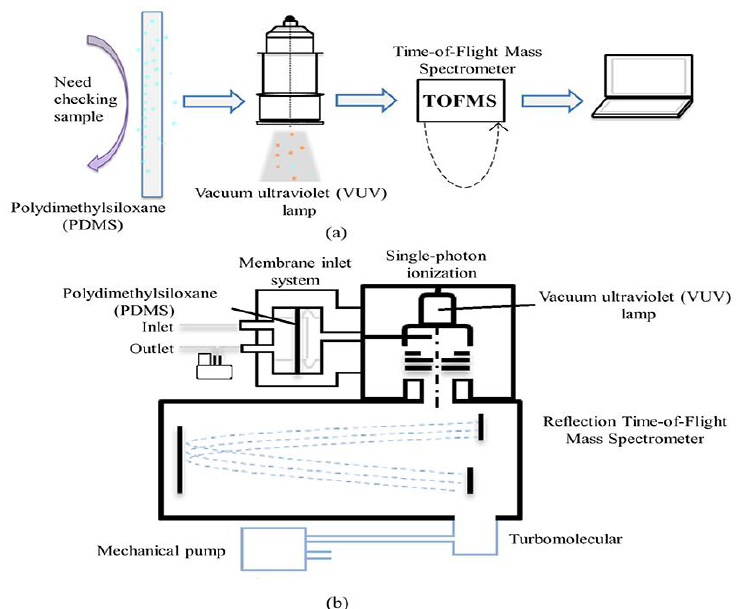
Figure 1. The SPI-TOFMS schematic diagram. ( a ) The schematic for the simple principle component and ( b ) the schematic cross-sectional diagram for each part of the SPI-TOFMS.